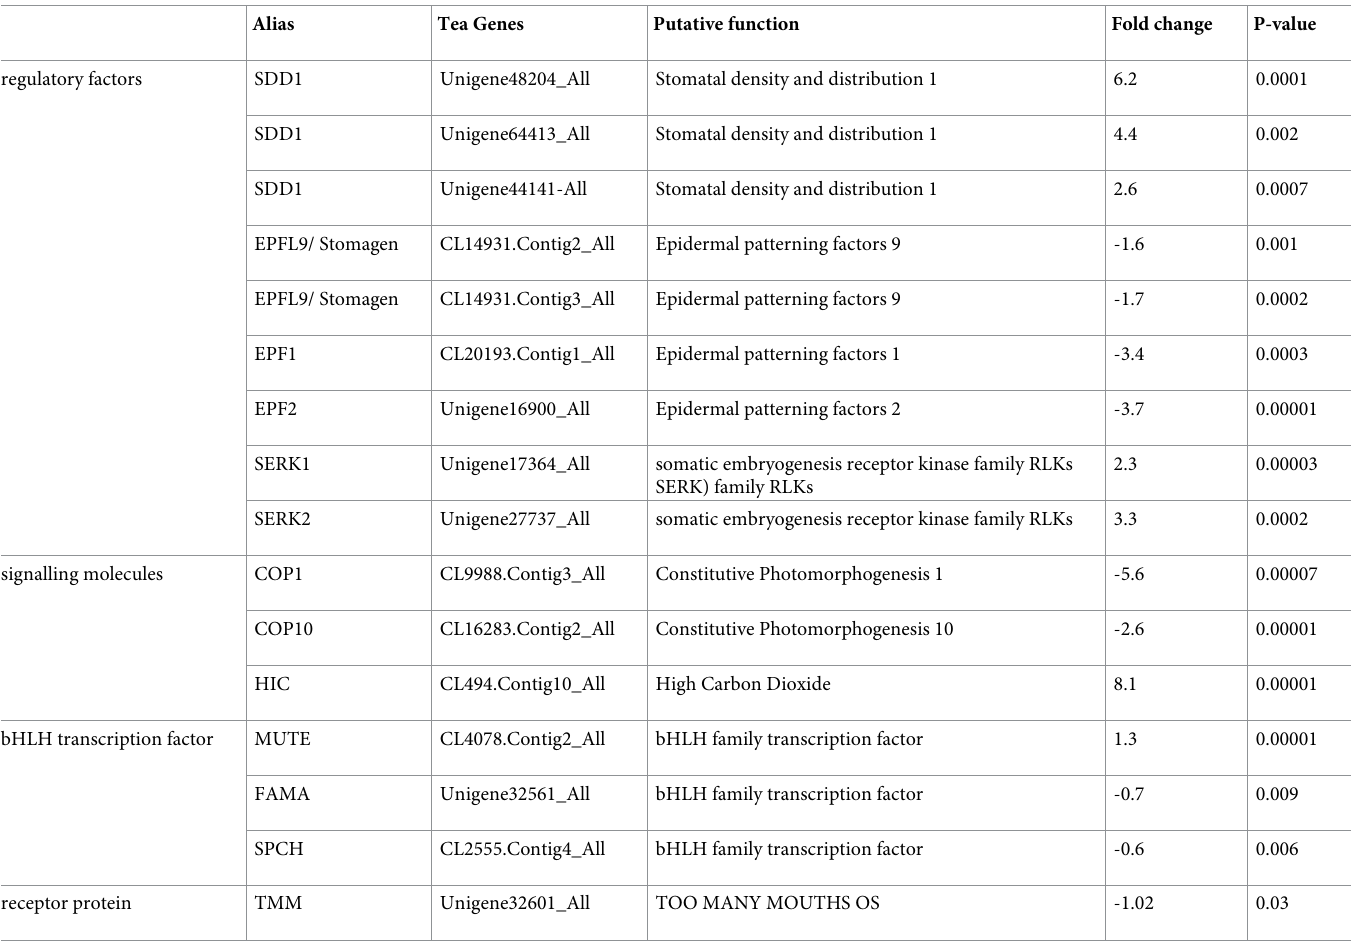
Table 2. Differentially expressed genes (DEGs) related to stomatal development in diploid and triploid. Alias Tea Genes Putative function Fold change P-value regulatory